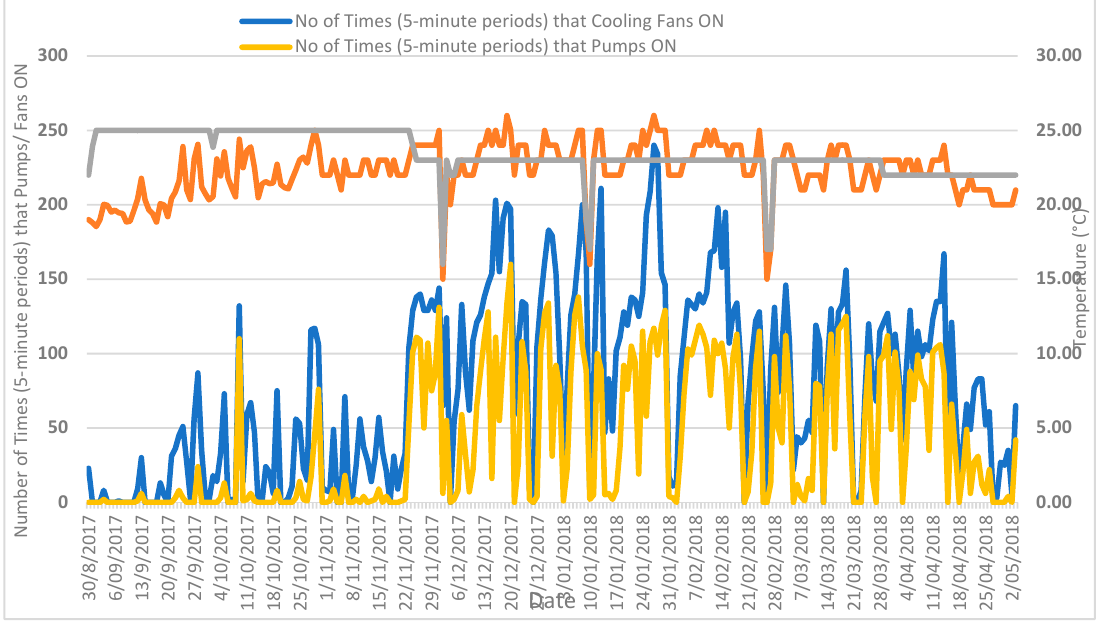
Figure 1. Active and measured temperatures and power consumption by fan and pump cooling systems over the full capsicum crop lifecycle.